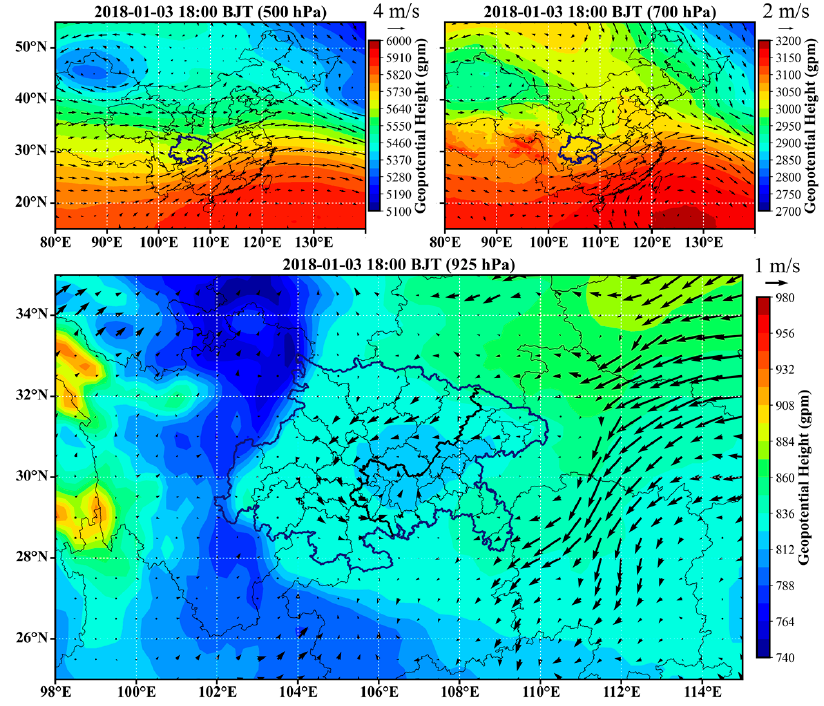
Figure 6. Typical circulation features in winter. The arrows represent horizontal wind vectors.